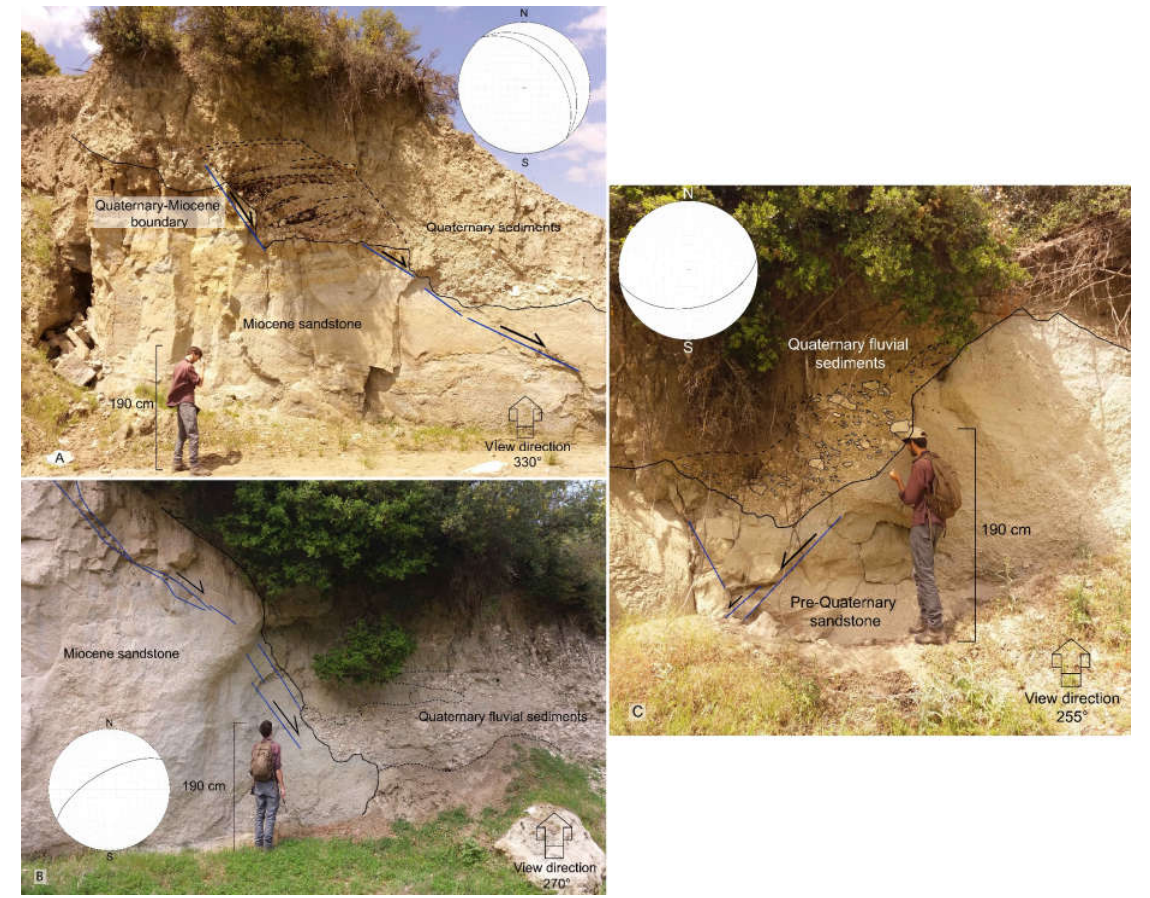
Figure 12. Clast wedges along fault scarps. Sedimentation is typically seen on the hanging wall in response to the footwall erosion. X-Y-Z coordinates: ( A ) 652573-4285333, 435 m. ( B ) 655015-4280973, 504 m. ( C ) 652625-4283997, 471 m. UTM Zone 35 coordinates.